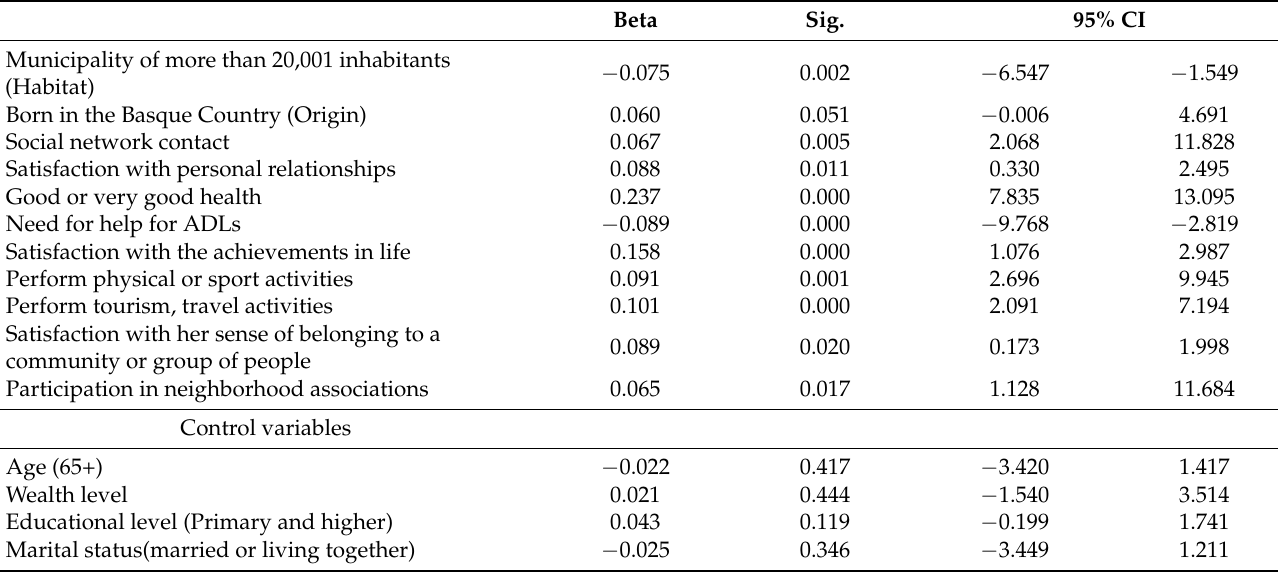
Table 6. Model weights of each predictor and their significance on the dependent variable for women. Beta